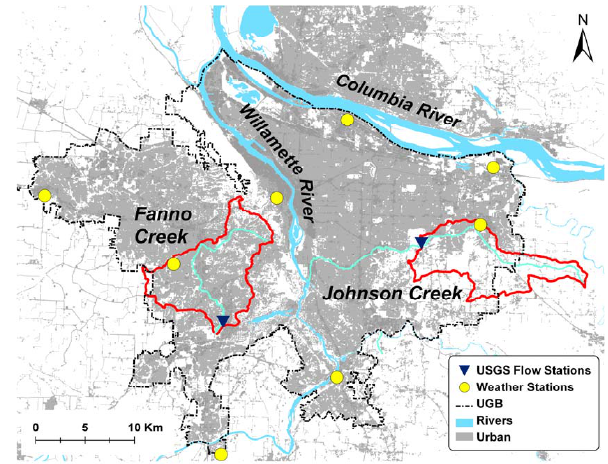
Fig. 1. Fanno and Johnson Creek catchment boundary, river network, and the Portland urban growth boundary (UGB) 4 5